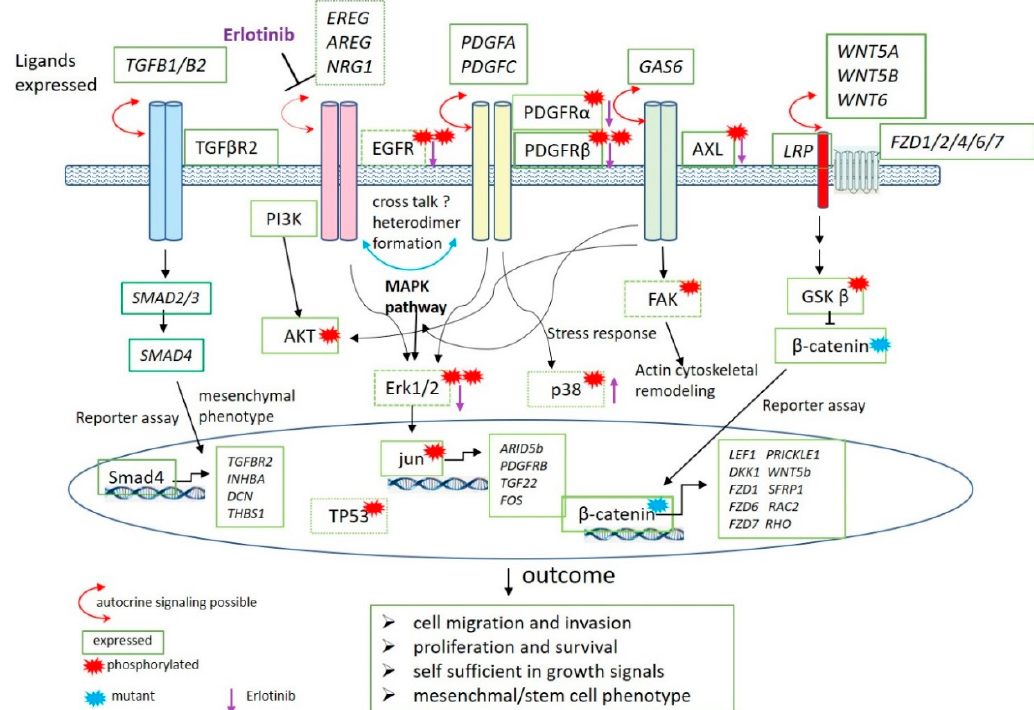
Figure 7. Schematic representation of the data described in this report. The phosphorylated proteins as identified in proteome blots are marked with a red star. Proteins are not in italics and green boxes around the protein indicate the level of the respective RNA expression. The boxes have dark green line when the gene shows a high expression, lighter green corresponds to a lower expression and dotted boxes a low expression. The expressed genes are shown in italics and boxed in green. Included are the data obtained in reporter gene experiments. The location of the proteins in the cell and their function in the pathways is shown. The activity of proteins in the nucleus are indicated in the oval circle and the putative target genes induced by their activity are shown in italics. The mutant β -catenin protein as found in most of the cell lines is labeled with a blue star. The outcomes deduced from these activated pathways are shown below. A purple arrow shows the results of Erlotinib treatment of the cells. Arrow pointing down, less phosphorylation; arrow pointing up, more phosphorylation.